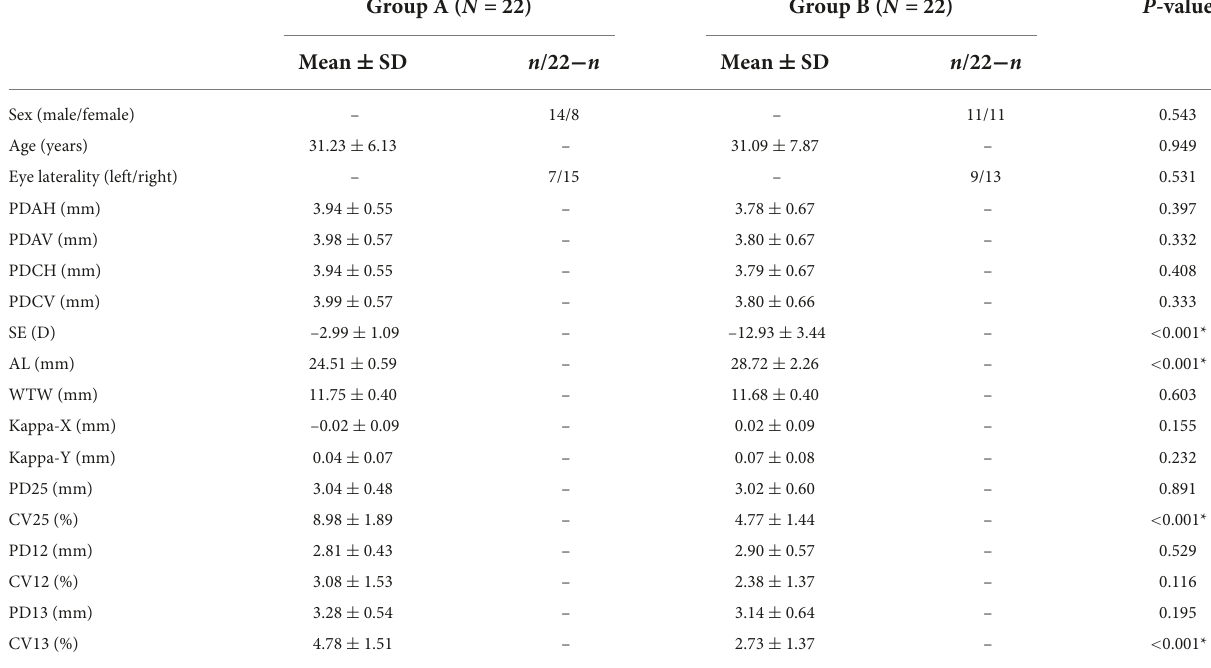
TABLE 1 Characteristics of ocular measurements in Group A and Group